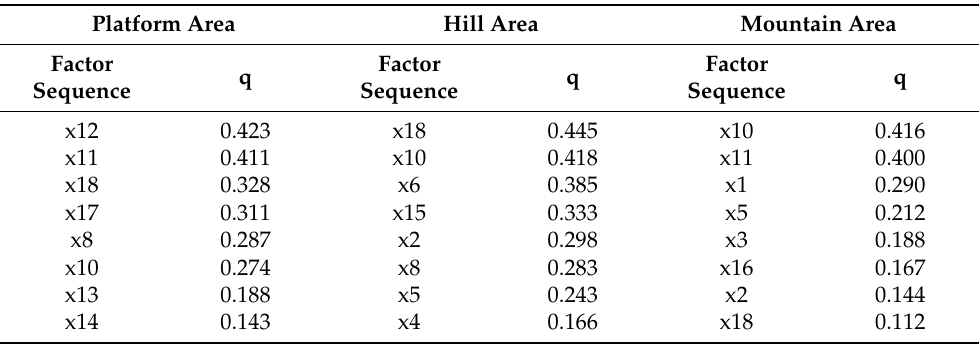
Table 6. Geographical exploration results of driving factors of residential land agglomeration in different types of